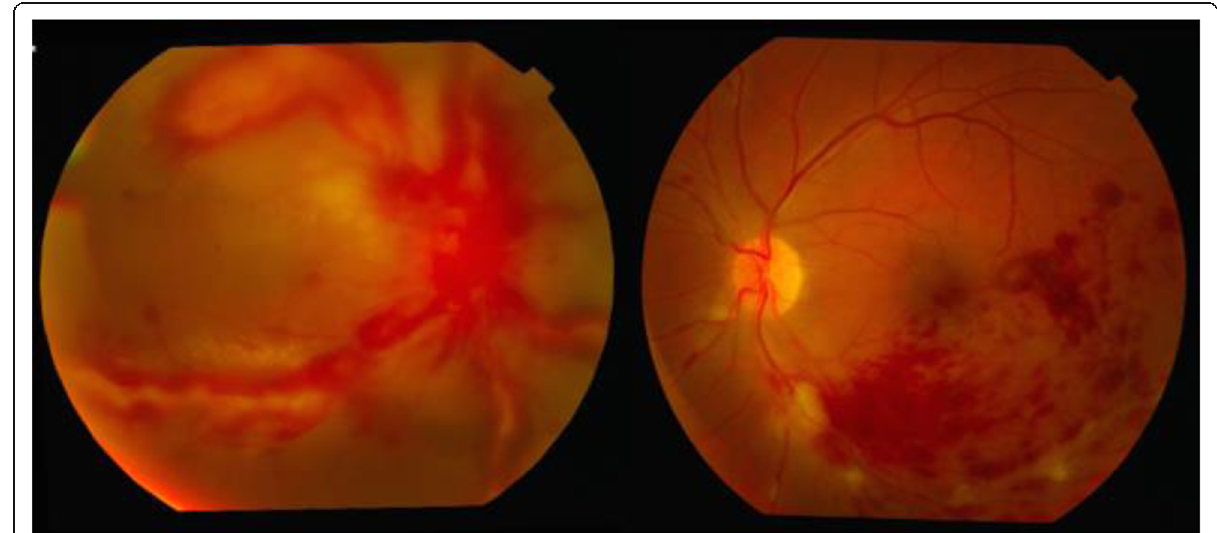
Fig. 1 Severe vasculitis involving major vessel arcades in the right eye (left); inferotemporal vein occlusion with hemorrhages in the left eye